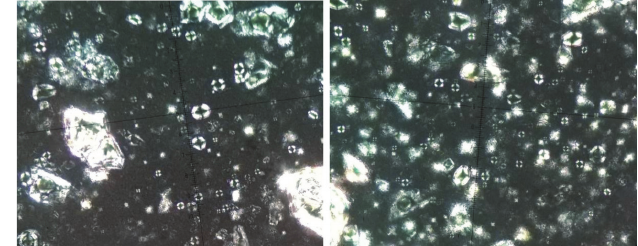
FIGURE 7 - Photomicrographs of the formulations not containing (left) and containing (right) GB soft extract.